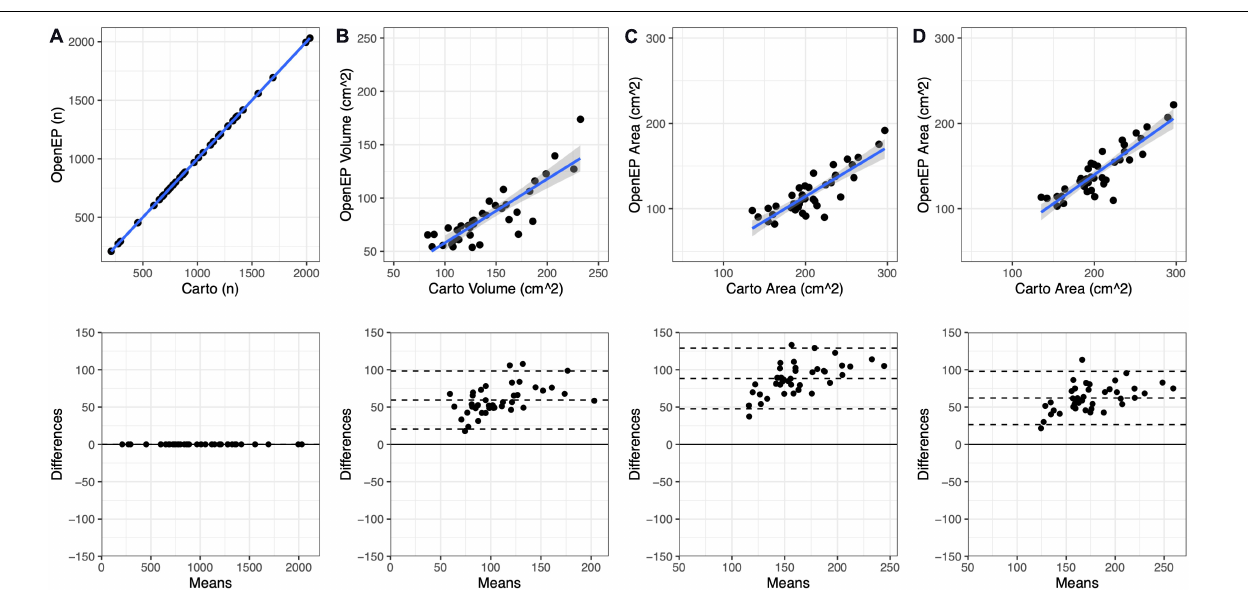
FIGURE 3 | Geometric measurements compared between the original electroanatomic mapping system and OpenEP. (A) Number of mapping points present in the original Carto map and subsequently identified by OpenEP, using getNumPts(userdata) . (B) Chamber volume measured by Carto and OopenEP, using getVolume(userdata) . (C) Chamber area measured by Carto and OpenEP, using getArea(usredata, 'method', 'nofill' ). (D) Chamber area measured by Carto and OpenEP, using getArea(usredata, 'method', 'fill')